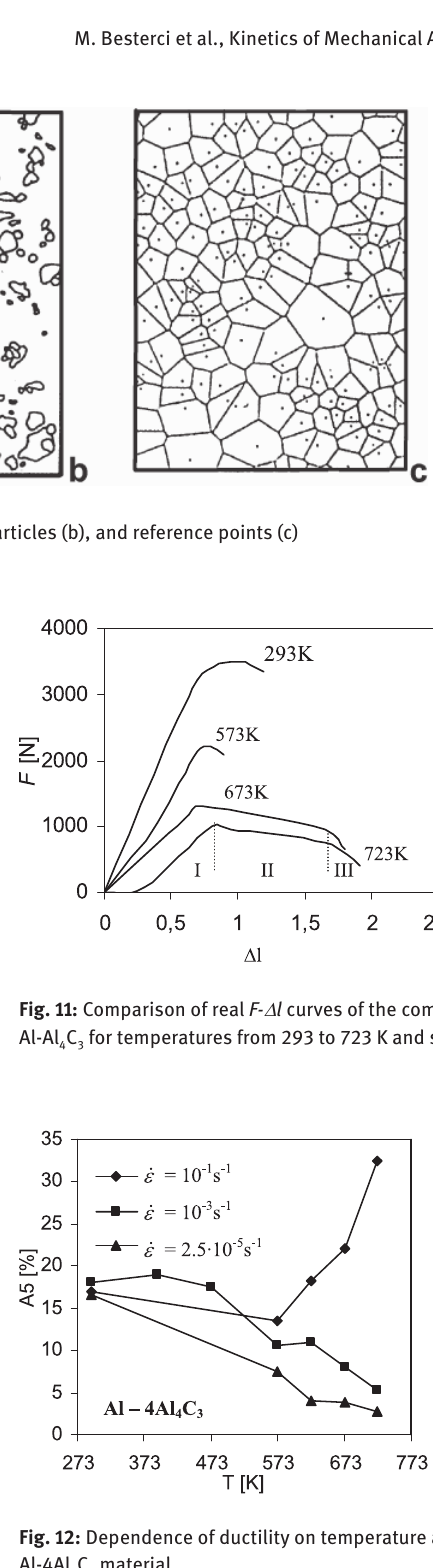
with dynamic recovery, and only after that the part ( III ), with the loss of plastic stability. The plastic properties are expressed by ductility A Fig. 12 for different strain rates. For low strain rates a